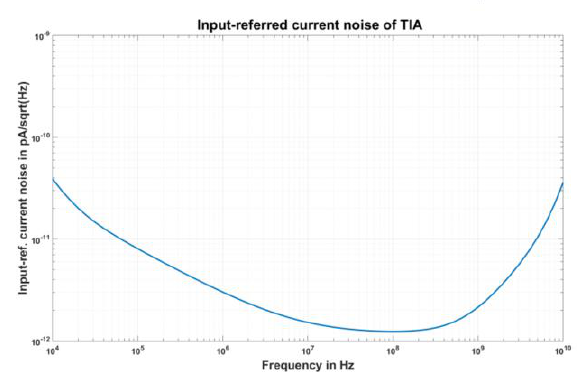
Fig. 6. Simulation results for input-referred current